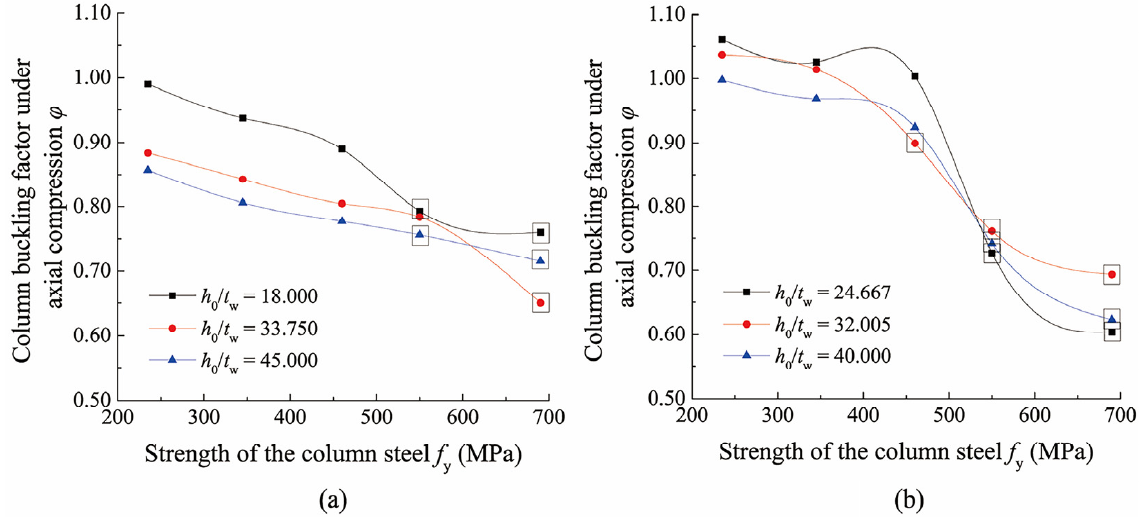
Figure 18. Relationship between column buckling factor and yield strength of column steel for var- ying web height-to-thickness ratio: ( a ) Model M4- h 0 / t w , ( b ) Model M6- h 0 / t w .